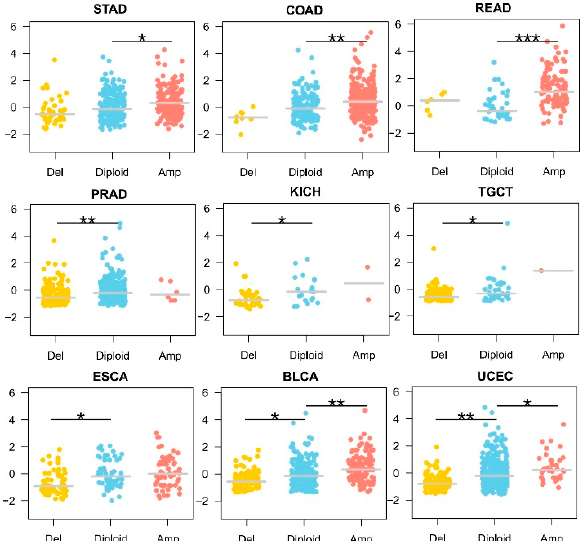
Figure 2. Relationship between KLF5 copy number and gene expression in different tumor types. In gastrointestinal tumors with predominantly KLF5 amplification, including gastric cancer (STAD), colon cancer (COAD), and rectum cancer (READ), an increase in KLF5 transcripts could be observed (top 3 figures). For prostate cancer (PRAD), kidney chromophobe (KICH), and testicular germ cell tumors (TGCT), KLF5 deletion is predominant, and a decrease in KLF5 transcription could be observed (middle 3 figures). For other tumor types such as esophageal carcinoma (ESCA), bladder urothelial carcinoma (BLCA) and uterine corpus endometrial carcinoma (UCEC), which have comparable rates of KLF5 amplification and deletion, KLF5 copy number changes and gene expression shows a dose-response relationship (bottom 3 figures). * 0.05 < p < 1 × 10 − 4 , ** 1 × 10 − 4 < p < 1 × 10 − 6 , *** p < 1 × 10 − 6 .